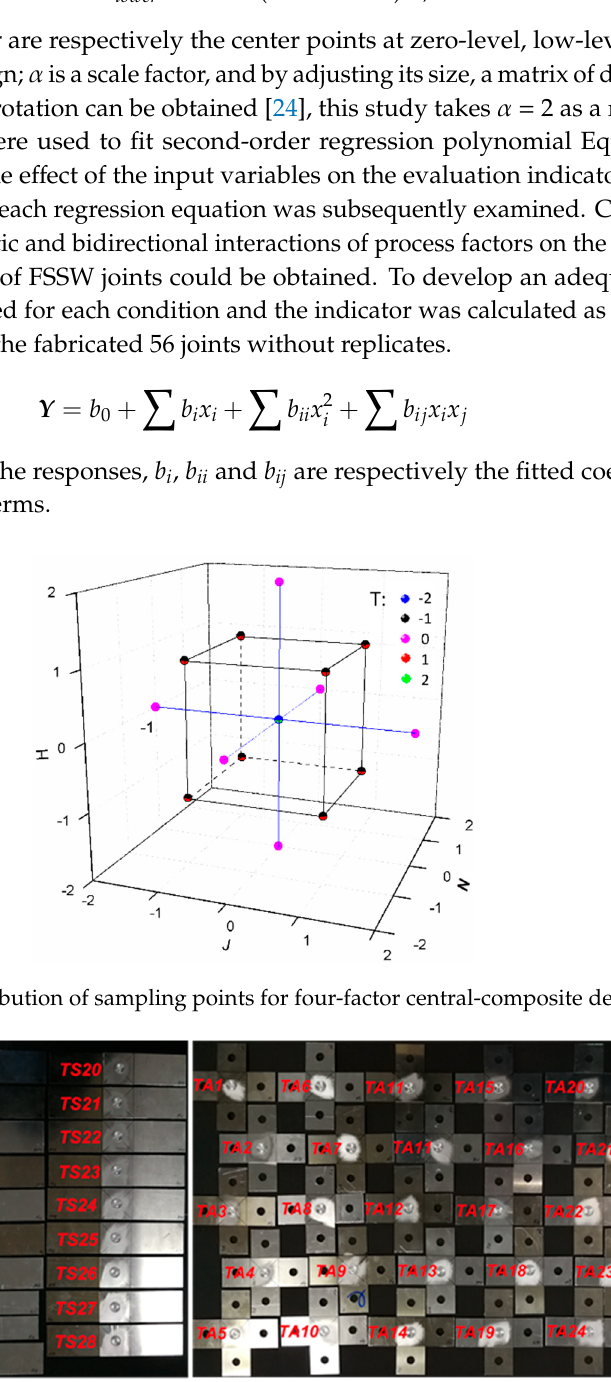
Figure 3. A photograph of friction stir spot-welded lap shear and cross tensile specimens using both automotive aluminum alloys.